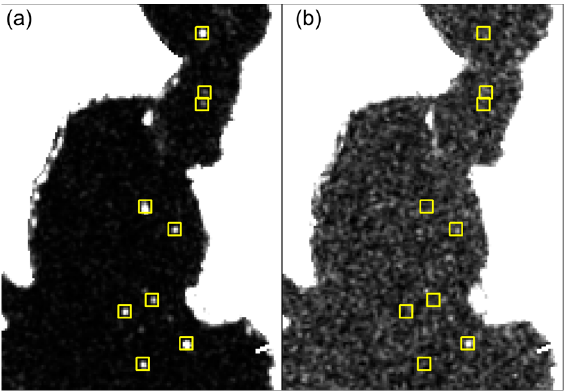
Figure 4. Boat visibility in a Sentinel-1 image (yellow squares represent boats): ( a ) VV polarization and ( b ) VH polarization.